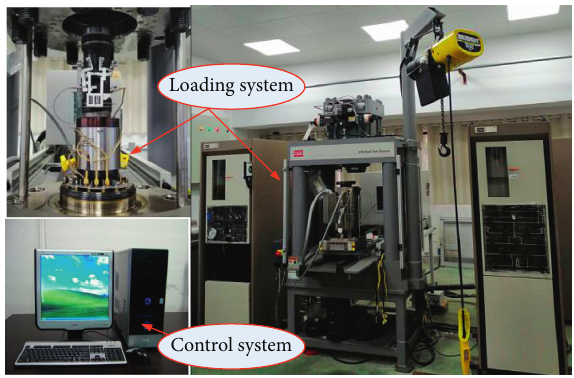
Figure 2: Test system of